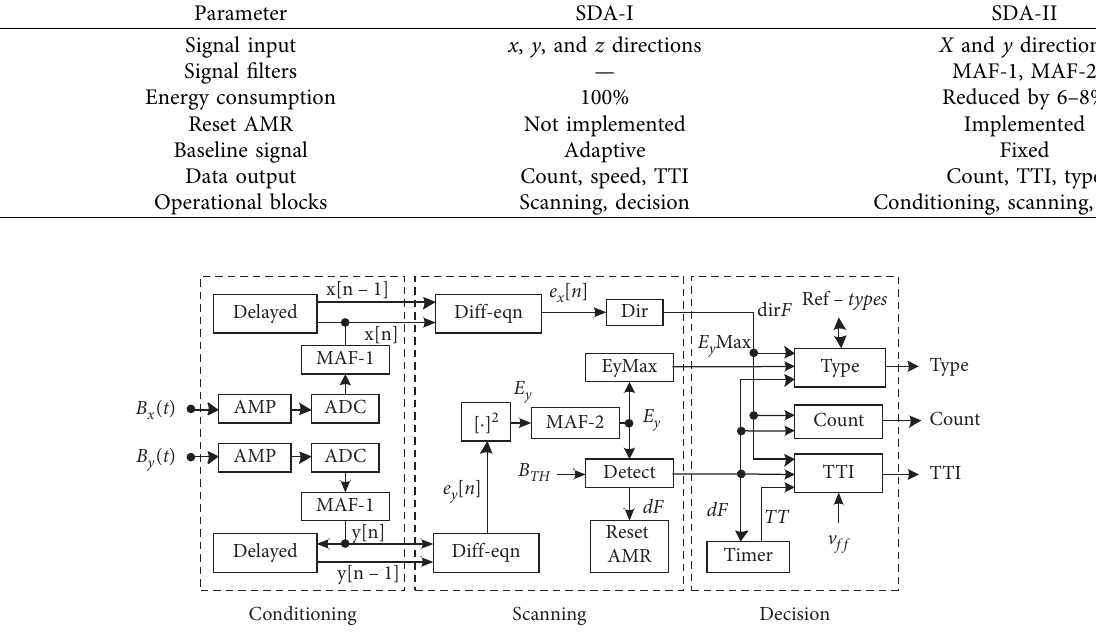
Figure 1: SDA-II